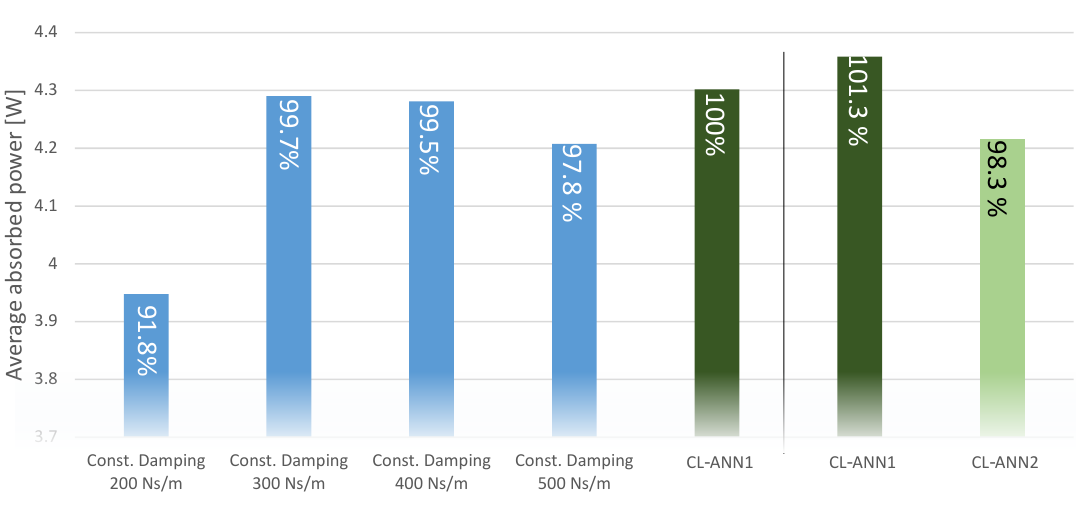
Figure 7. Average absorbed power for the test wave sequence in the simulations. CL-ANN1 indicates the ‘deep’ ANN, and CL-ANN2 the ‘shallow’